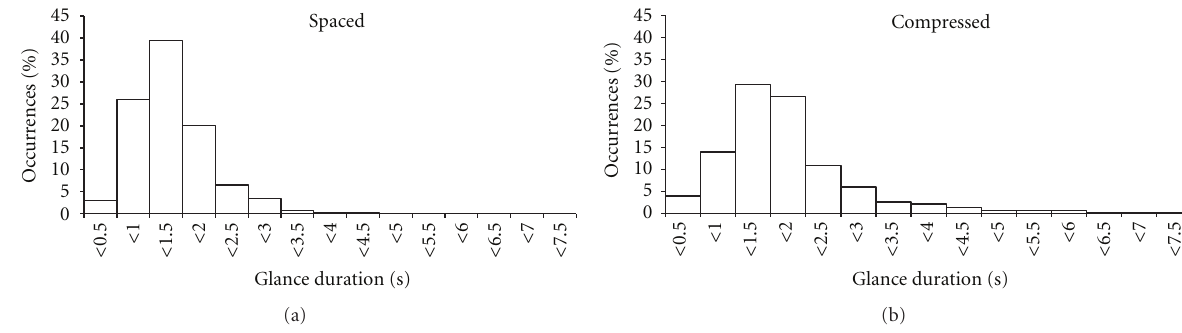
Figure 4: The distributions of glance durations by text type in Experiment 2.